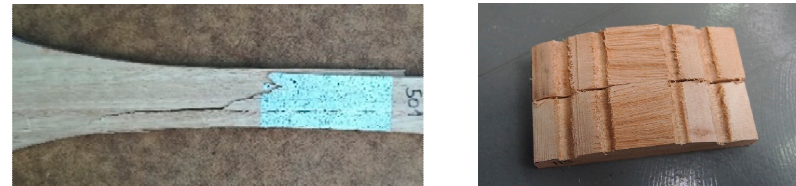
Figure 4. Typical failures in tension parallel to grain ( left ) and tension perpendicular to grain ( right ).